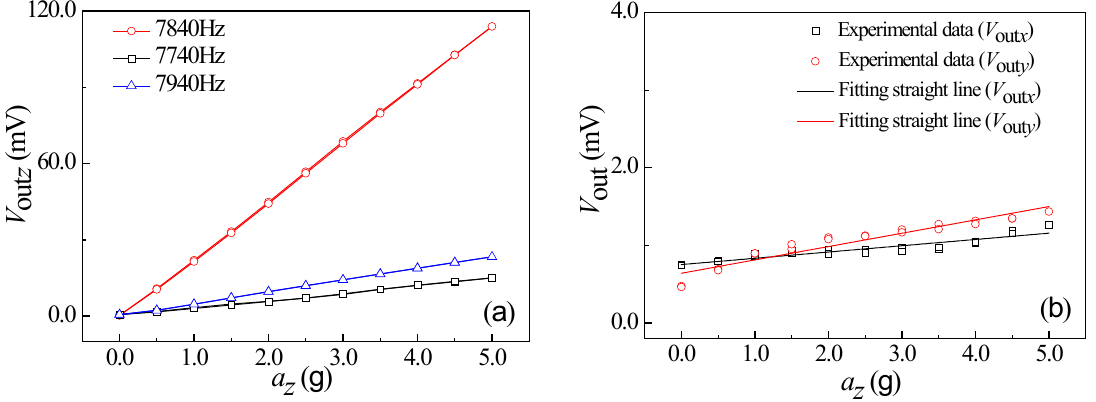
Figure 11. The relationship curves of output voltage and a z . ( a ) The characteristic curves of differential frequency variation. ( b ) The relationship curves between V out along nonsensitive axis and a z .